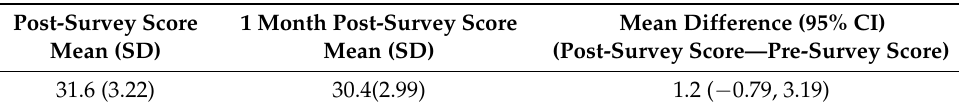
Table 3. Differences between the post-survey score and post-one-month-survey score among all 55